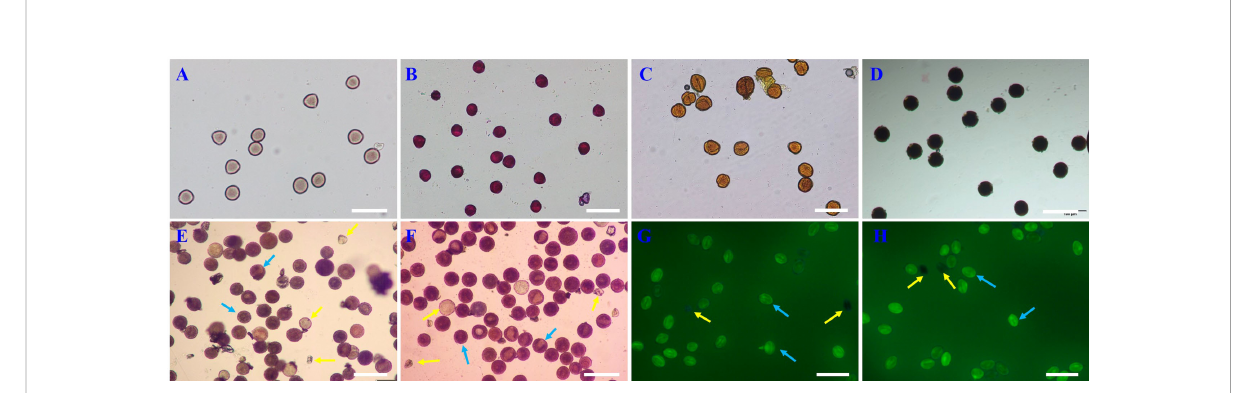
FIGURE 3 Comparison of the seven staining methods for E racemosa pollen. (A) Carmine acetate; (B) Alexander; (C) I-KI 2 ; (D) MTT; (E) TTC; (F) Red ink; (G, H) fl uorescein diacetate. The yellow arrow indicates non-viable pollen; the blue arrow indicates viable pollen. Bar = 100 m